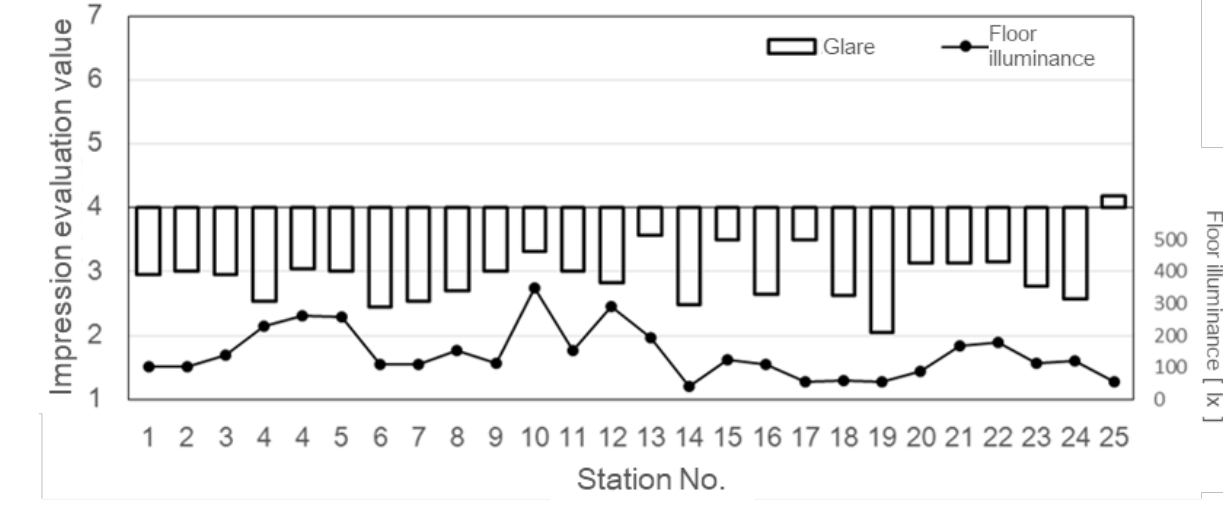
Figure 13. Results of impression evaluation of glare and floor illuminance.